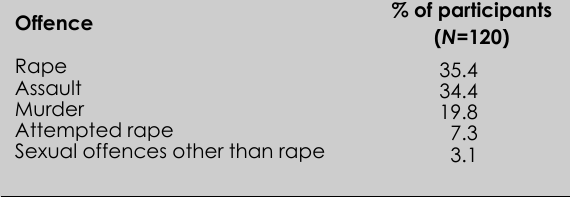
Table II. Offences committed against persons